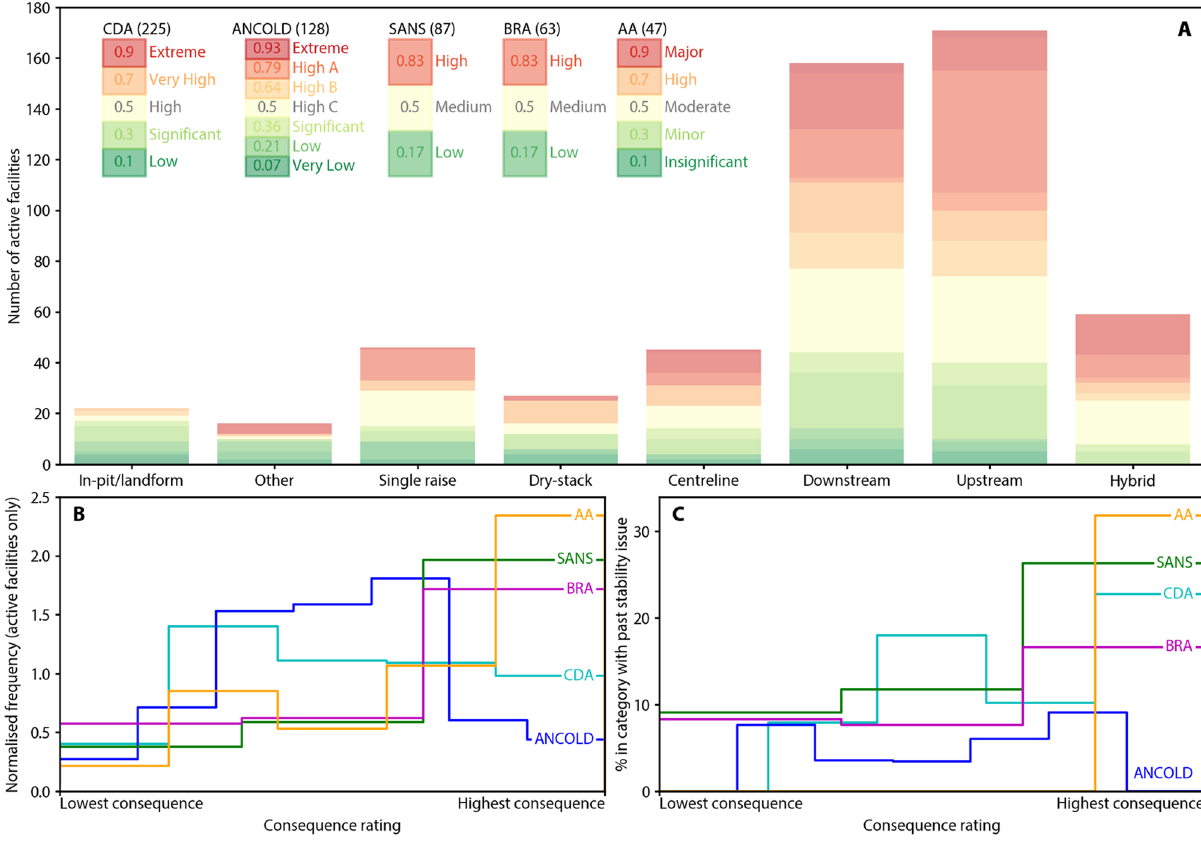
Figure 4. Consequences of facility failure. ( A ) Consequence of failure by facility raise type (active facilities) for the five most common consequence classification schemes ( CDA Canadian Dam Association, ANCOLD Australian National Committee on Large Dams, SANS South African National Standards, BRA Brazilian Ordinance 70.389/17, AA Anglo American Technical Standard). ( B ) Distribution of active facilities by consequence rating for the five most common consequence classification schemes. To allow comparison of the distributions, the frequency of the Y-axis is normalised so that the area under each consequence classification curve is the same. ( C ) Proportion of sites reporting a stability issue by consequence of